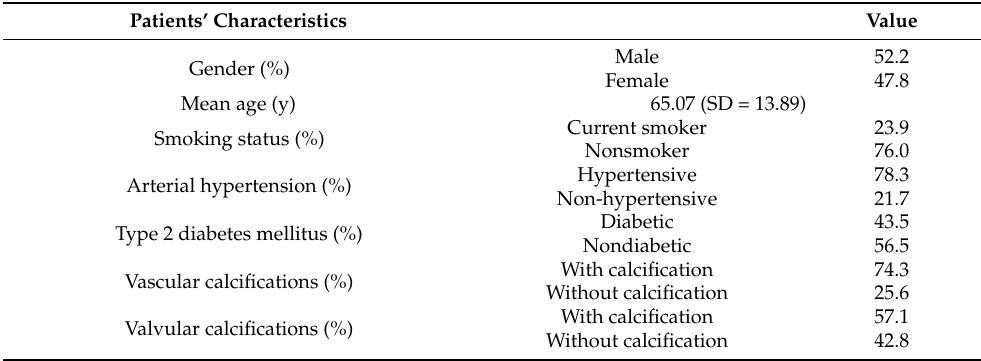
Table 1. Patients’ demographic characteristics, and clinical and biochemical